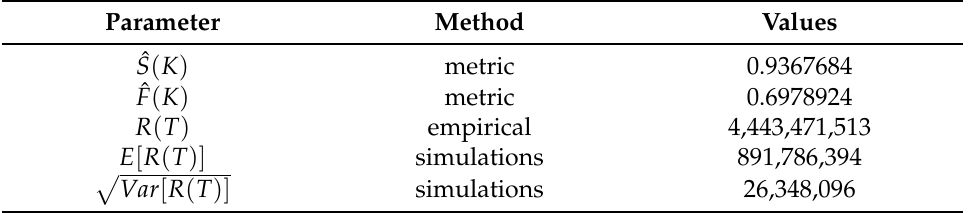
Table 7. The result of the comparison between an empirical risk process and simulations of the general compound Hawkes process at time T = 184 in Group 1.